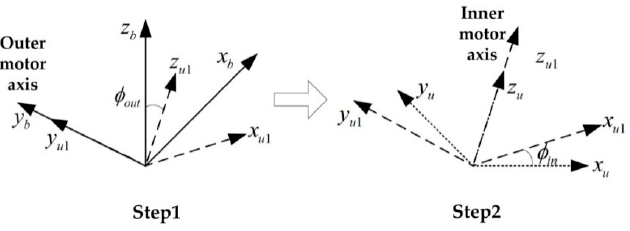
Figure 2. Relationship between body frame and IMU frame.